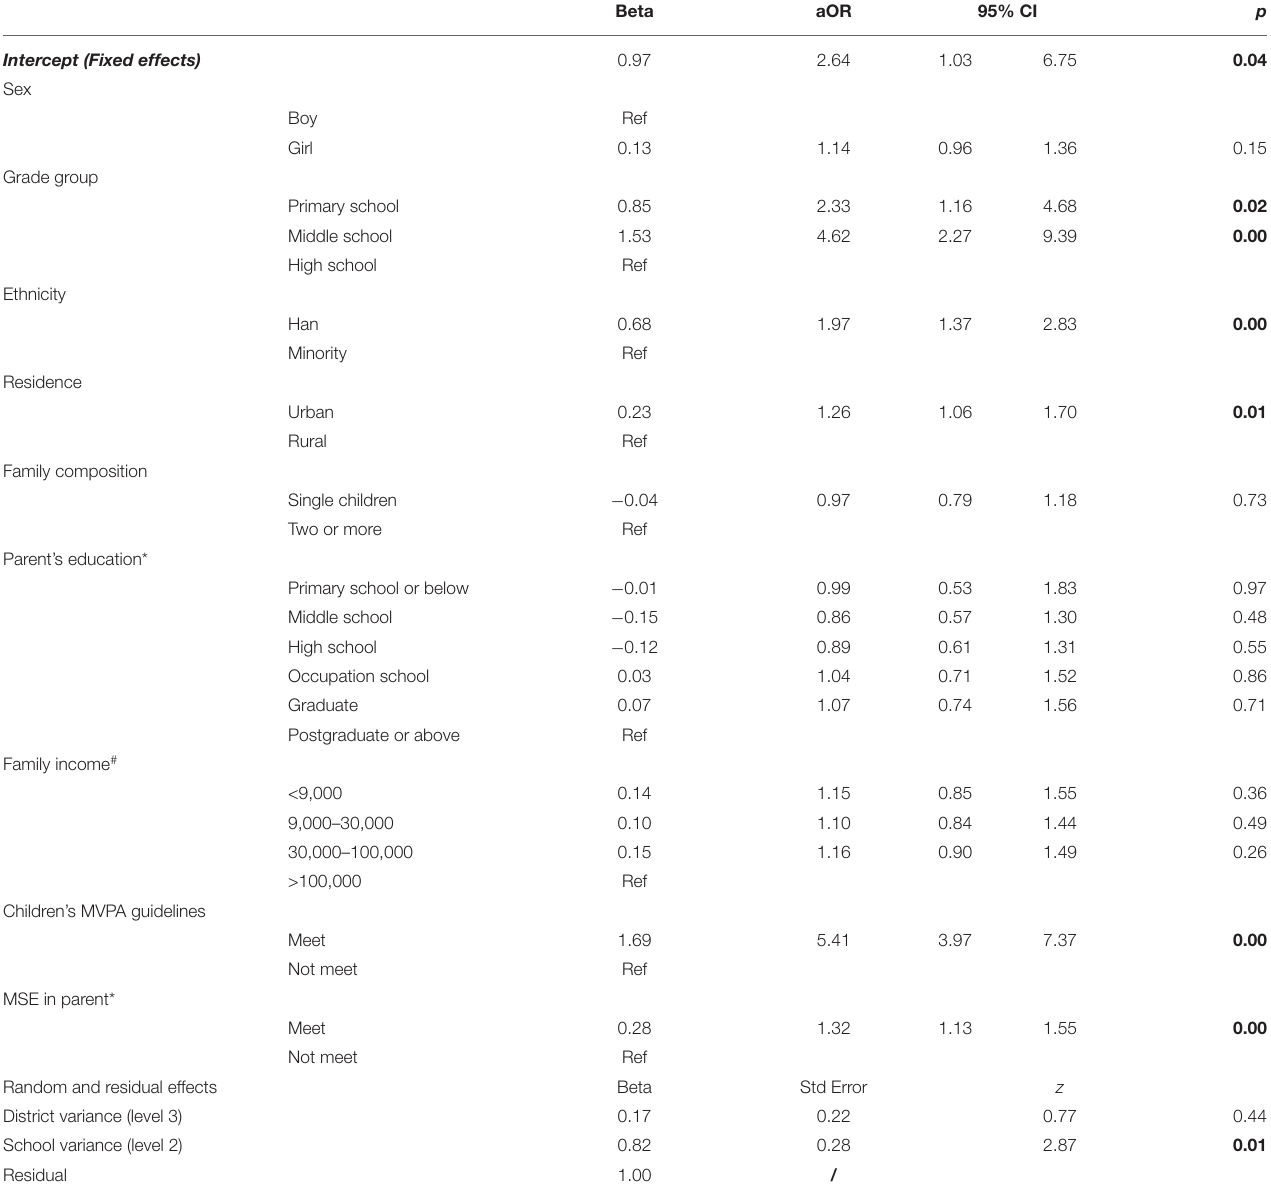
TABLE 3 | The association between the potential correlates with meeting the MSE